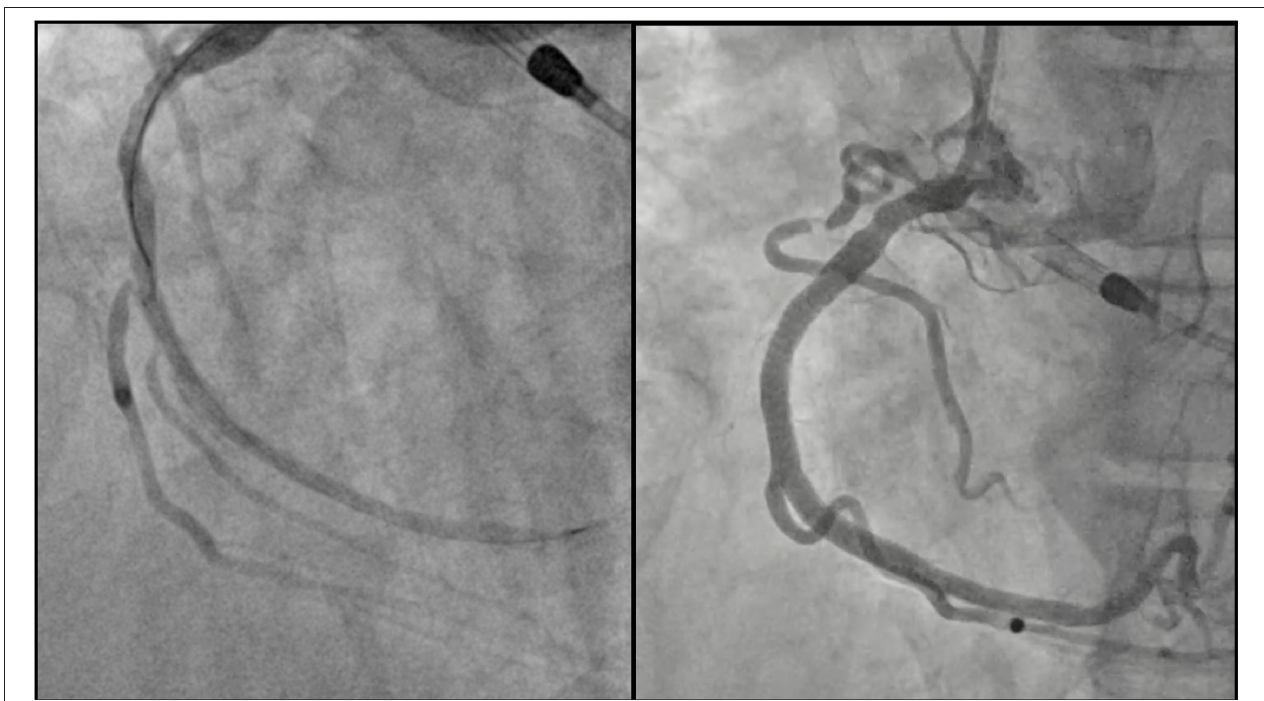
FIGURE 4 | Right coronary artery after PCI. Left panel : result after predilatation. A severe stenosis of the marginal branch ostium is shown. Note the Supercross 120 ◦ microcatheter that was used to wire the branch. Right panel : final result after deployment of the Tryton side branch stent in the marginal branch and multiple drug-eluting stent implantation in the right coronary